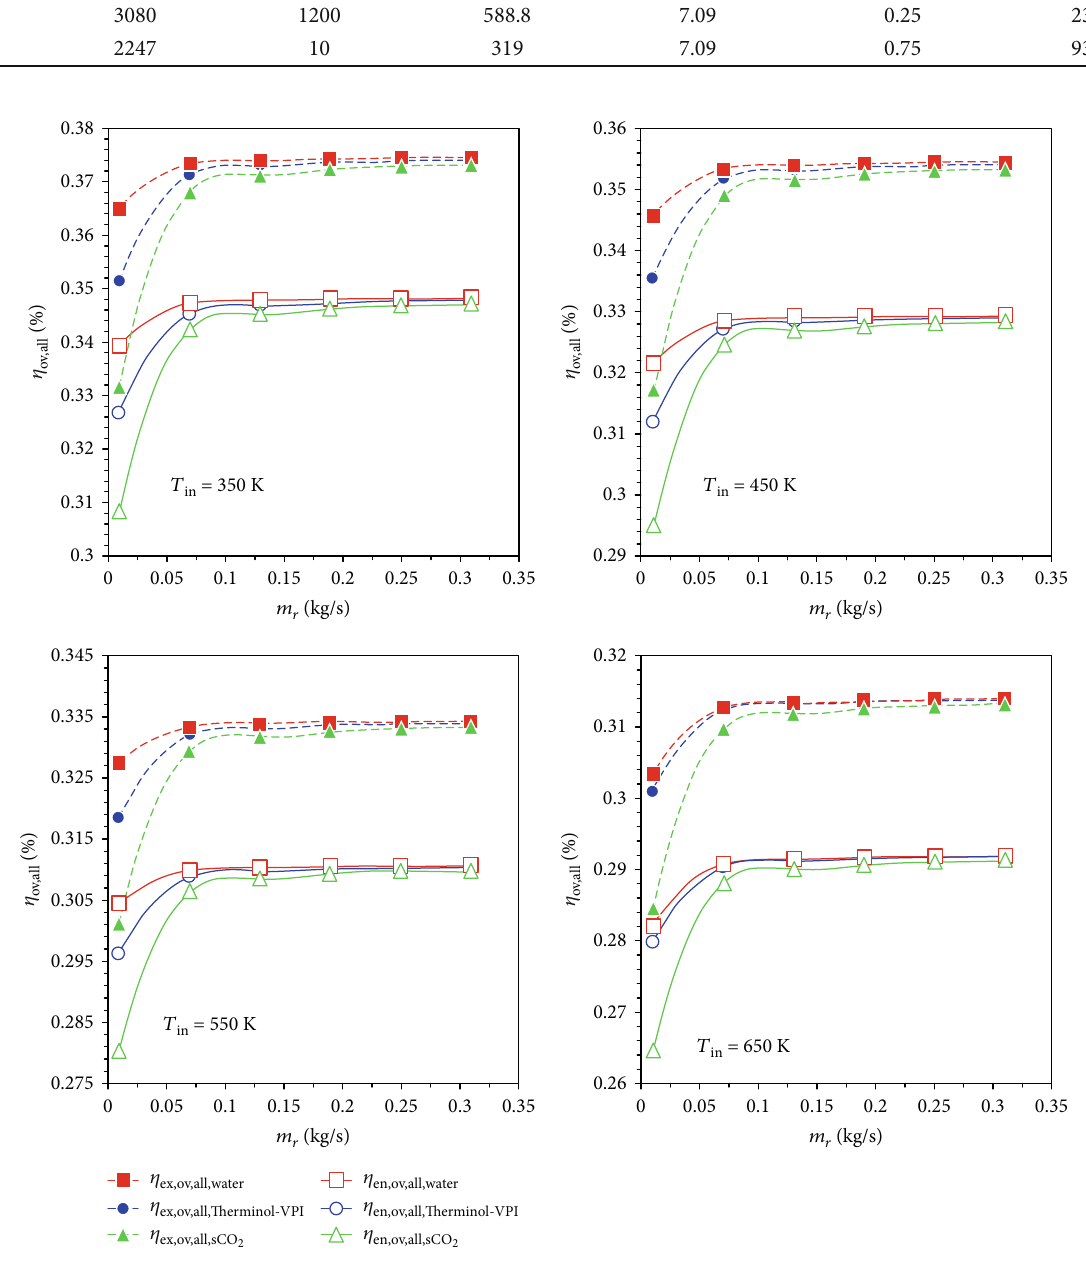
Figure 2: E ff ect of the mass fl ow rate on system-integrated e ffi ciencies for various inlet temperature